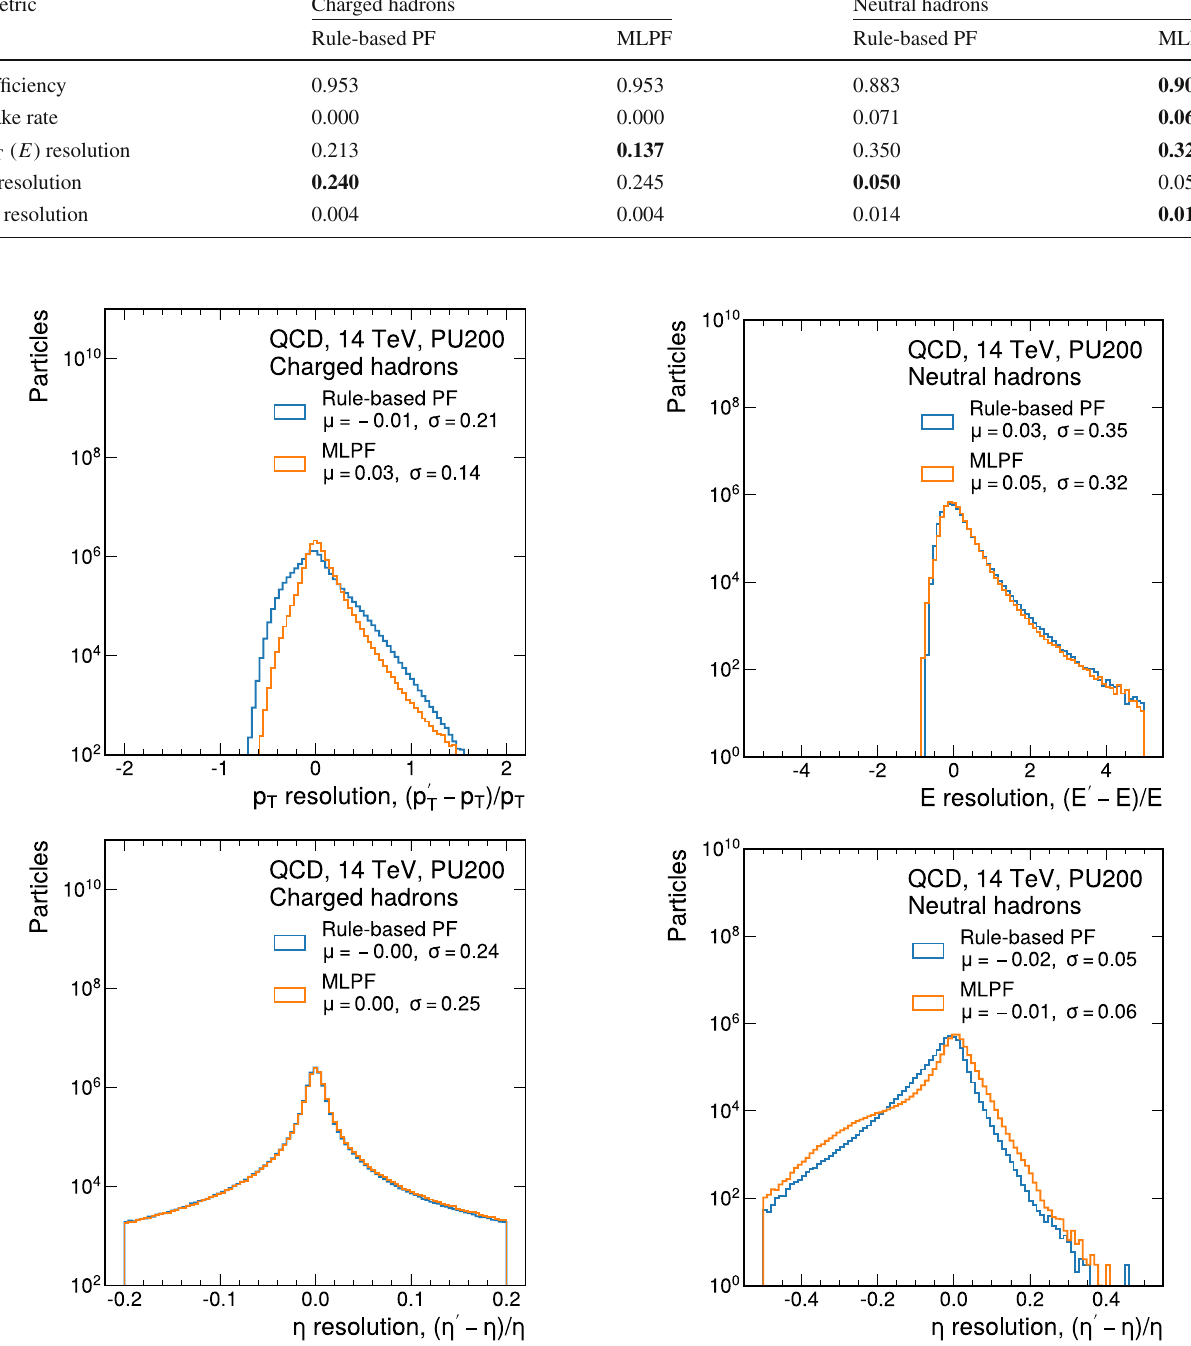
Fig. 10 The energy and η resolutionof the delphes PFbenchmark and the MLPF model for neutral hadrons in simulated QCD multijet events